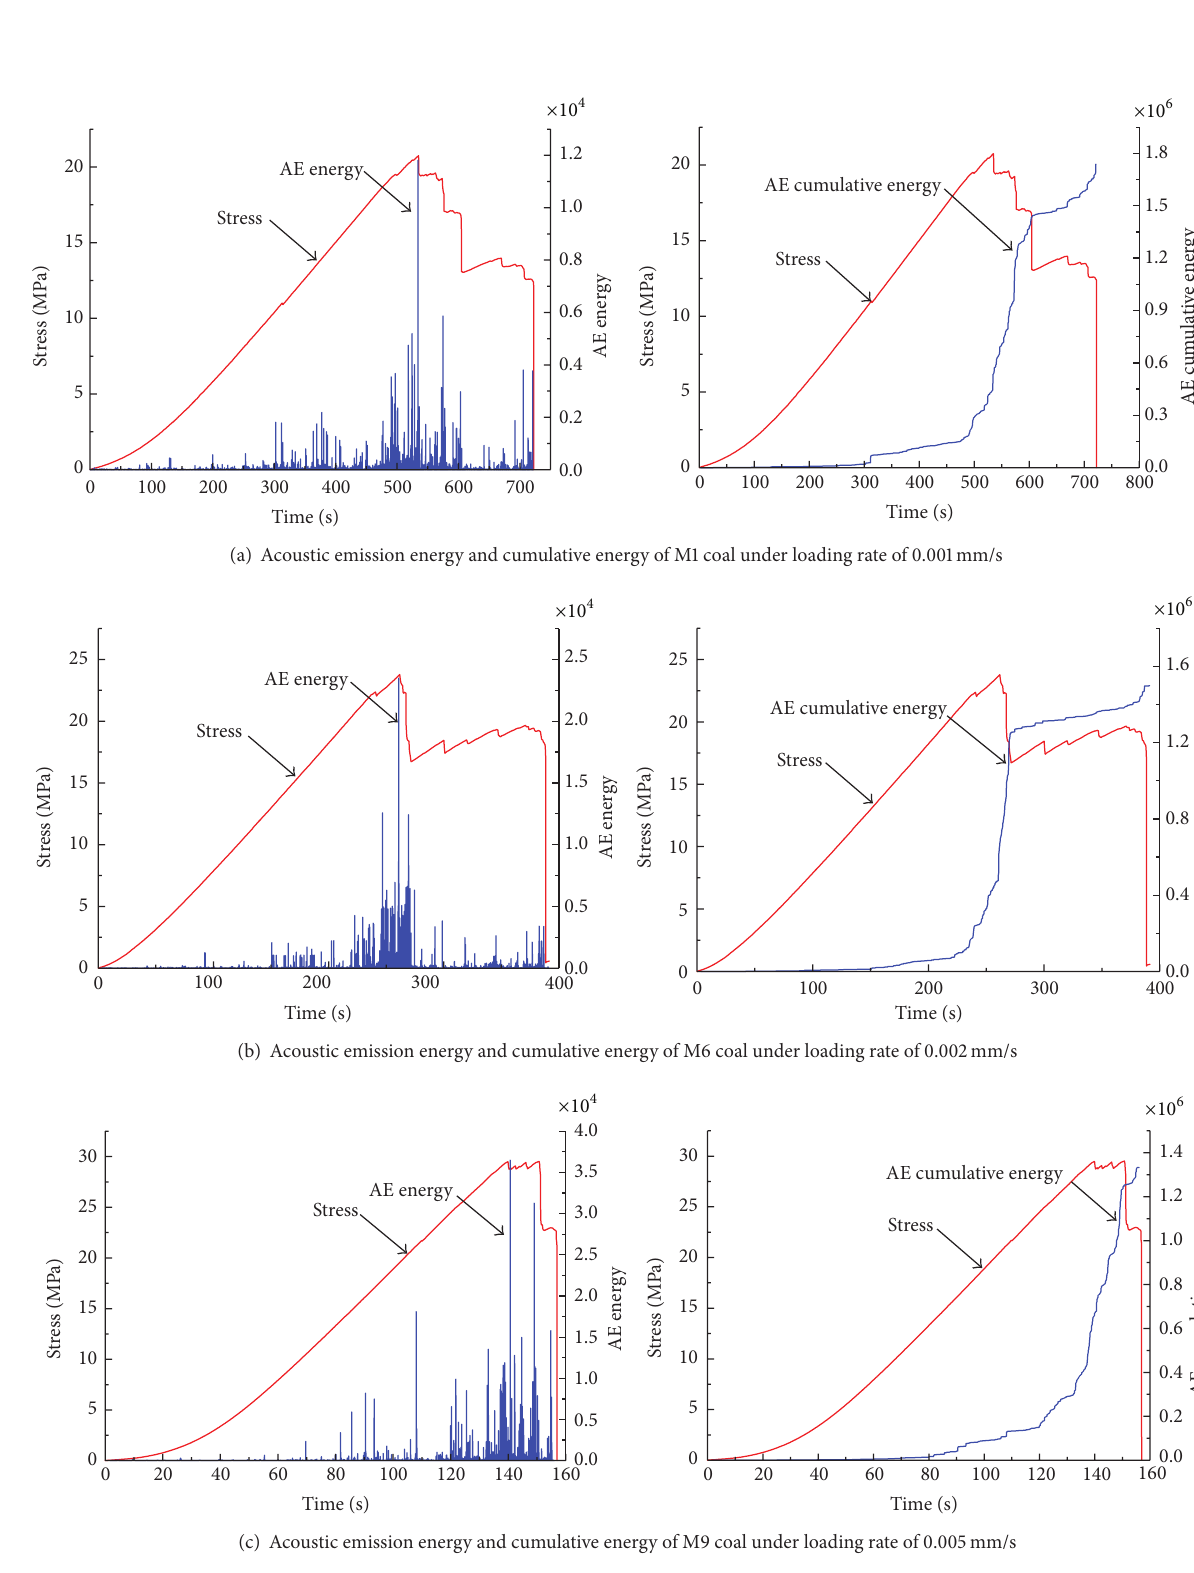
Figure 9: The relationship curve between time and AE energy, AE cumulative energy of the coal samples under different loading